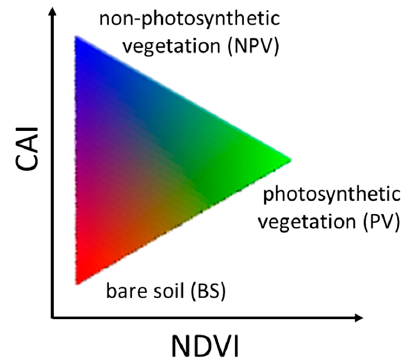
Figure 2. Conceptual relationship between components of fractional cover; Photosynthetic Vegetation (PV), Non-Photosynthetic Vegetation (NPV), and Bare Soil (BS) cover along Cellulose Absorption Index (CAI) and Normalized Difference Vegetation Index (NDVI) axes. Adapted from Guerschman et al. [31].